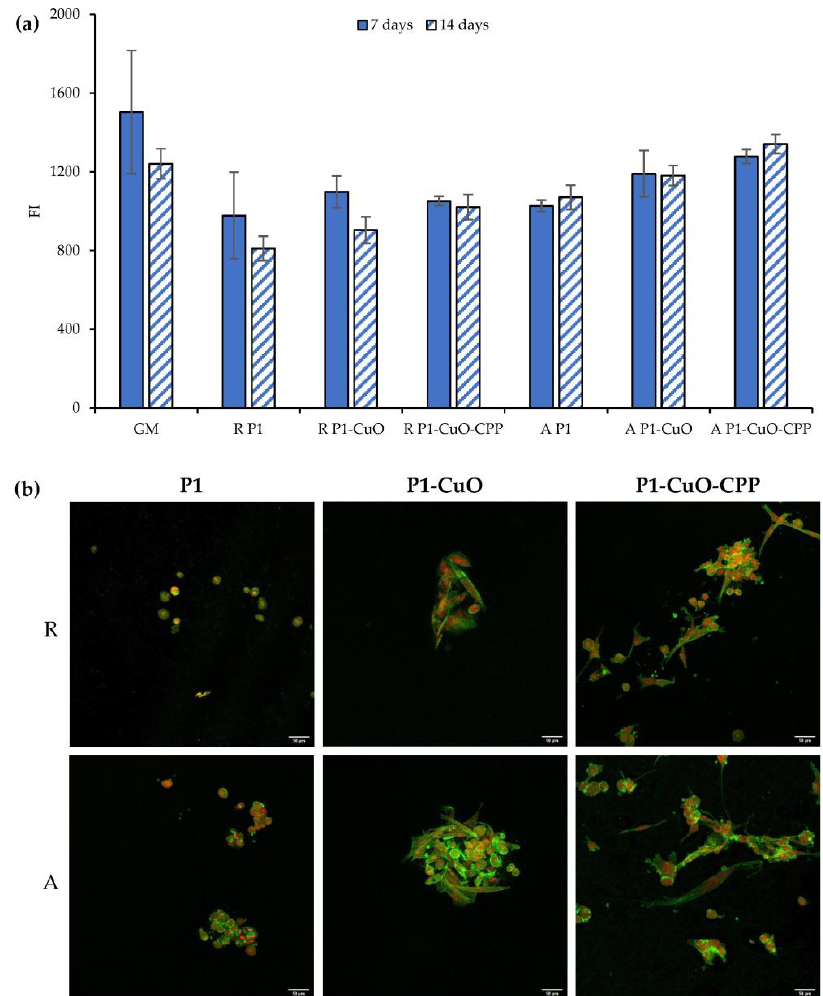
Figure 8. ( a ) Alamar Blue assay evaluated for P1, P1-CuO, and P1-CuO-CPP scaffolds, both random (R) and aligned (A), at 7 and 14 days of culture, compared to the cells grown in standard conditions (GM). ( b ) CLSM images of TEN-1 cells grown onto P1, P1-CuO, and P1-CuO-CPP scaffolds, random (R) and aligned (A), at 14 days of culture (nuclei stained in red, cytoskeleton stained in green) (mean values ± SD, n = 5). One-way ANOVA, Scheffé test ( p ≤ 0.05) is reported in the Supplementary Infor- mation (SI: Section S1.3.4).